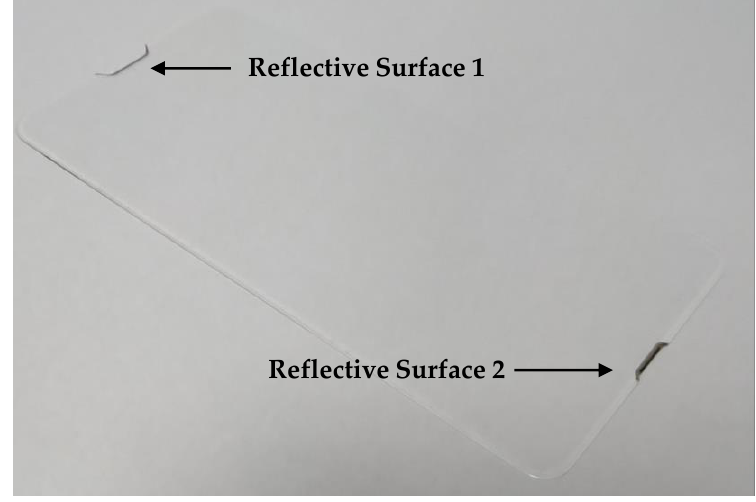
Figure 7. Cover glass processed according to Table 2 specifications, with lead angles added around the sides to avoid cracking.